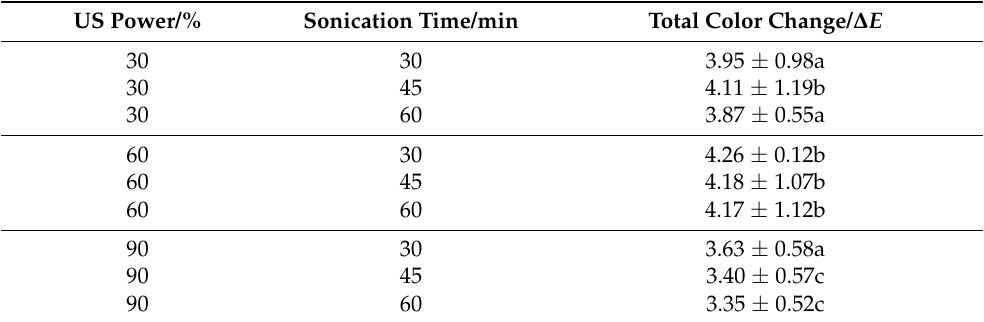
abc—different superscript letters within columns are significantly different ( p < 0.05). Table 6. Relationship between the ultrasonic parameters and drying